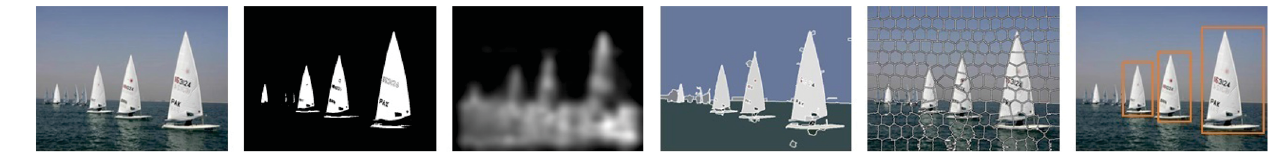
Fig. 2 Sample results produced by different models. Left to right: input image, salient object detection [27], fixation prediction [24], image segmentation (regions with various sizes) [28], image segmentation (superpixels with comparable sizes) [29], and object proposals (true positives)